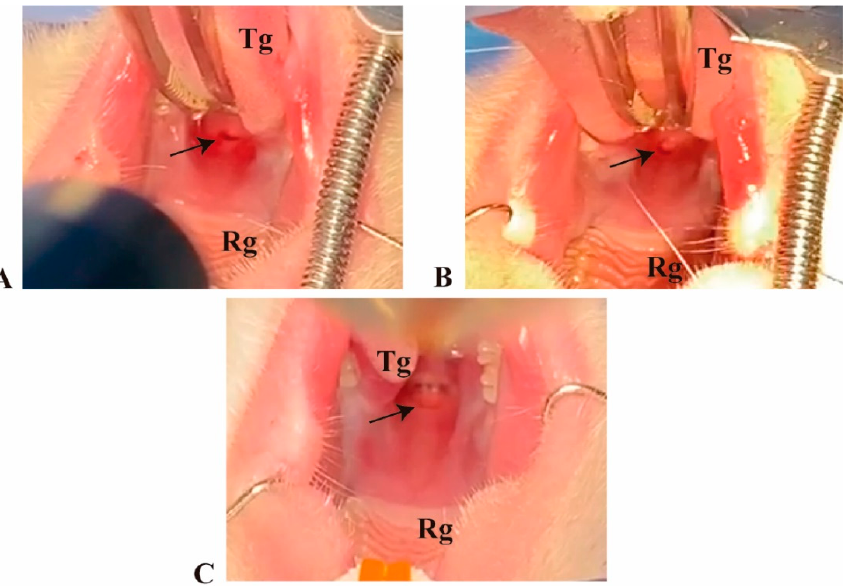
Figure 2. Fibrin construct at the day of wounding in the soft palate of the rat. The black arrows point to the wound site. ( A ) Excisional wound without implantation (W). ( B ) Fibrin-only implantation (WF). ( C ) Fibrin-laminin-nidogen implantation (WFL). Tg: tongue. Rg: Palatal rugae. Reversion of the anesthesia was obtained by atipamezole (Antisedan, Zoetis, Parsip- pany, NJ, USA) 1.25 mg/kg injected subcutaneously (0.1 mL/100 gr). The animals were placed in a pre-warmed cage and monitored for respiratory arrest and postoperative bleeding. During the next three days after surgery, weight loss, dehydration and activity were followed up for each animal. Post-operative analgesia with carprofen (Rimadyl, Zo- etis, Parsippany, NJ, USA) was provided in the drinking water.